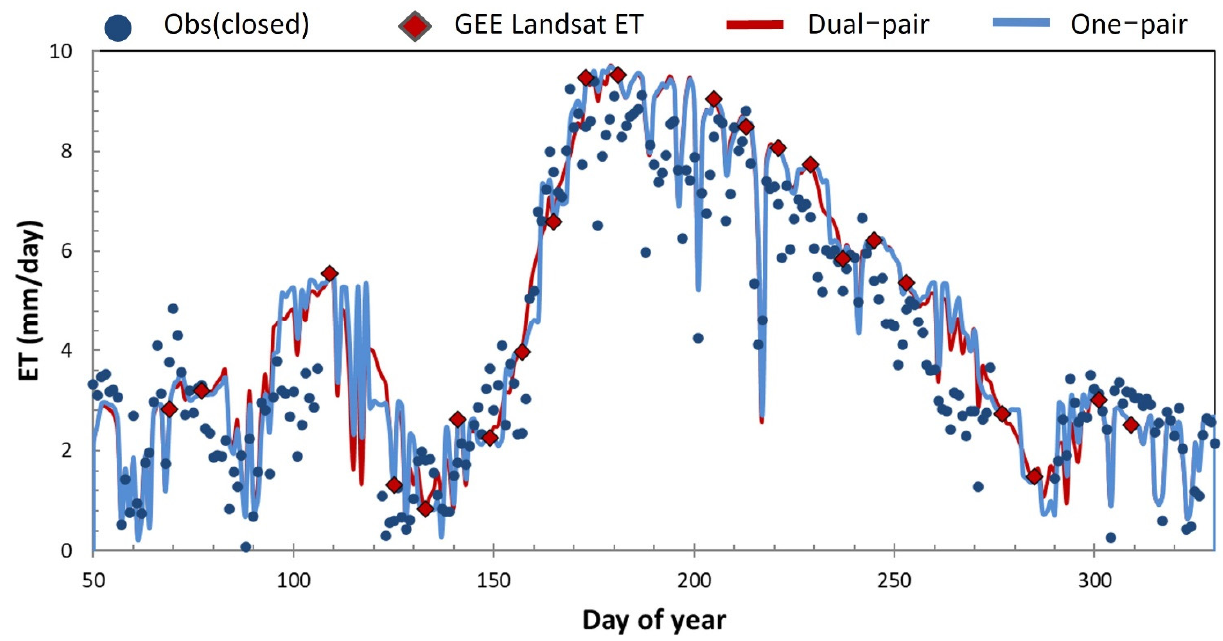
Figure 6. Comparison of observed flux tower ET and fused daily ET using dual-pair and one-pair STARFM over the US-Twt site in 2014.